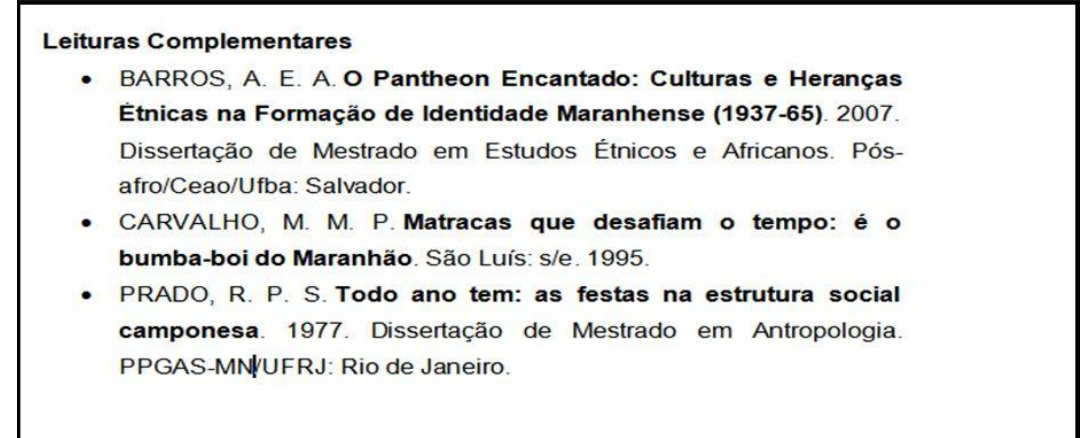
Figura 1- Sugestões de leituras complementares.